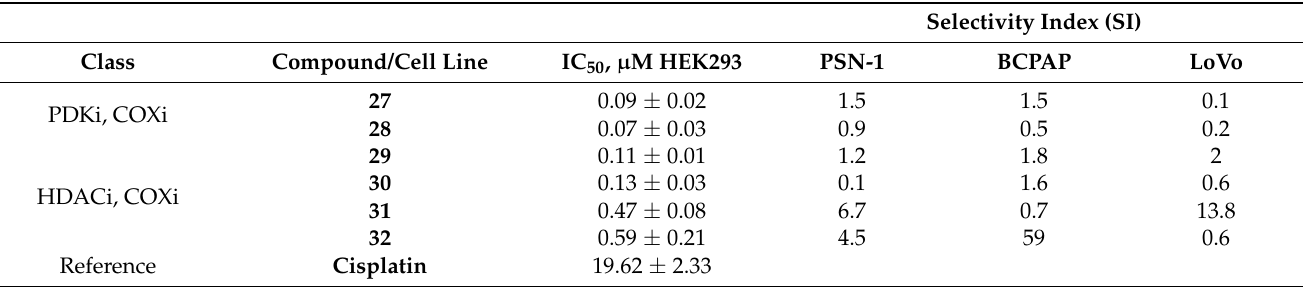
Table 16. Antiproliferative activity of platinum(IV) prodrugs 27–32 on HEK293 (non-cancerous embryotic kidney) cell line. Selectivity index (SI) = IC 50 (normal cell line)/IC 50 (tumor cell line).